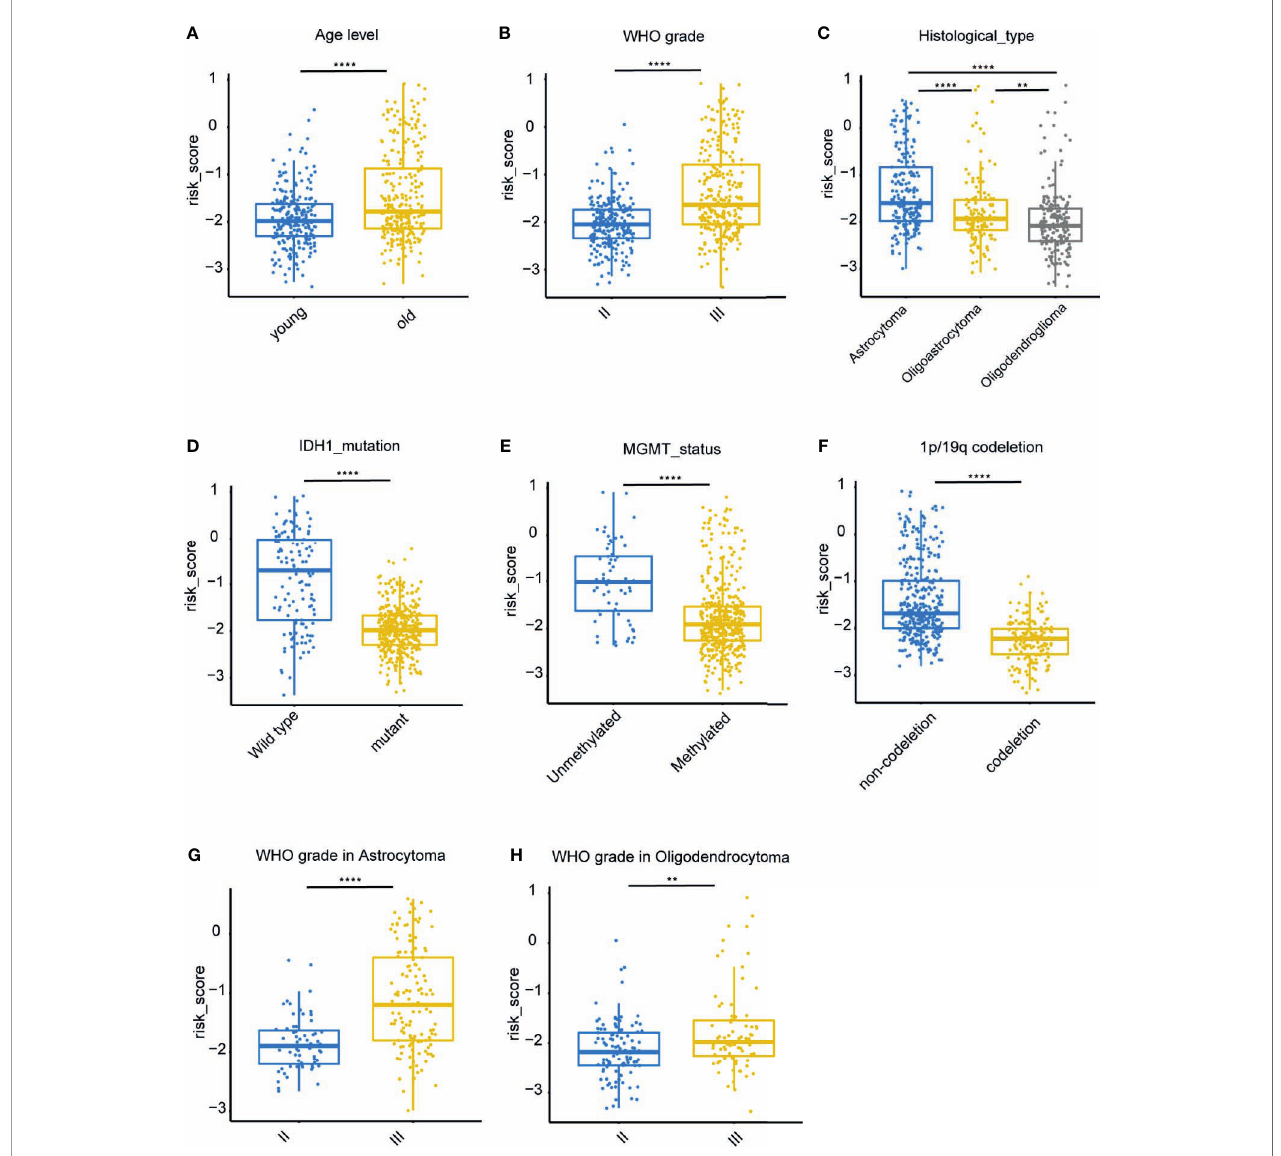
FIGURE 5 | Association between clinicopathologic features and the iron metabolism based risk score in the TCGA dataset. (A – F) , Risk-score distributions showed statistically signi fi cant differences in LGG patients strati fi ed by age, WHO grade, pathological types, IDH1 mutation status, MGMT promoter methylation status, and 1p/19q co-deletion status. (G) , Distribution of risk scores between WHO II and WHO III grade in astrocytoma patients. (H) , Distribution of risk scores between WHO II and WHO III grade in oligodendrocytoma patients. ** P < 0.005, **** P < 0.0001, ns, not signi fi